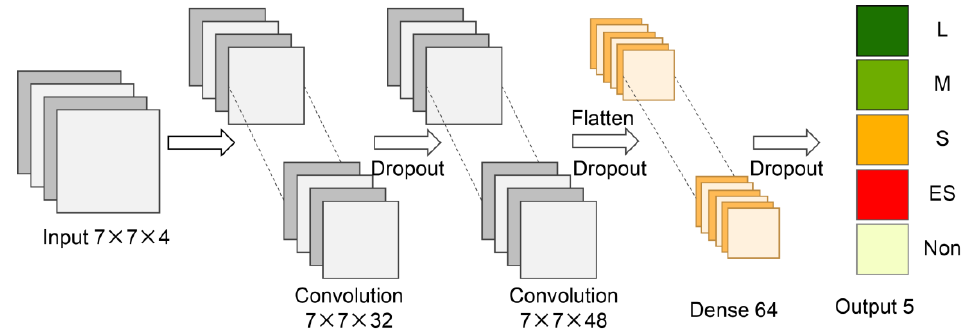
Figure 3. The convolutional neural network structure of this study. L—light desertification, M—moderate desertification, S—severe desertification, ES—extremely severe desertification, Non—non-desertification.